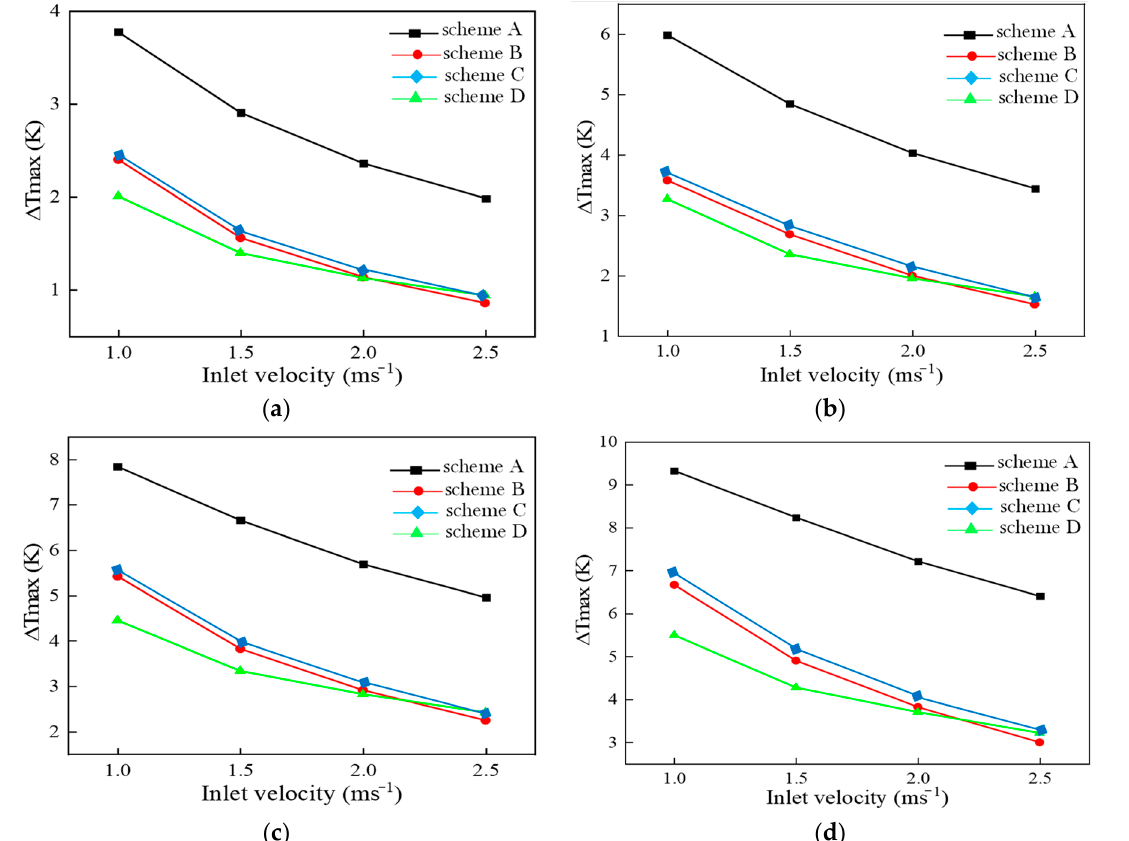
Figure 10. Variation of ∆ Tmax of scheme A, scheme B, and scheme D with inlet velocity. ( a ) The 2C Dr (discharge rates) discharge end; ( b ) 3C Dr discharge end; ( c ) 4C Dr discharge end; ( d ) 5C Dr discharge end.